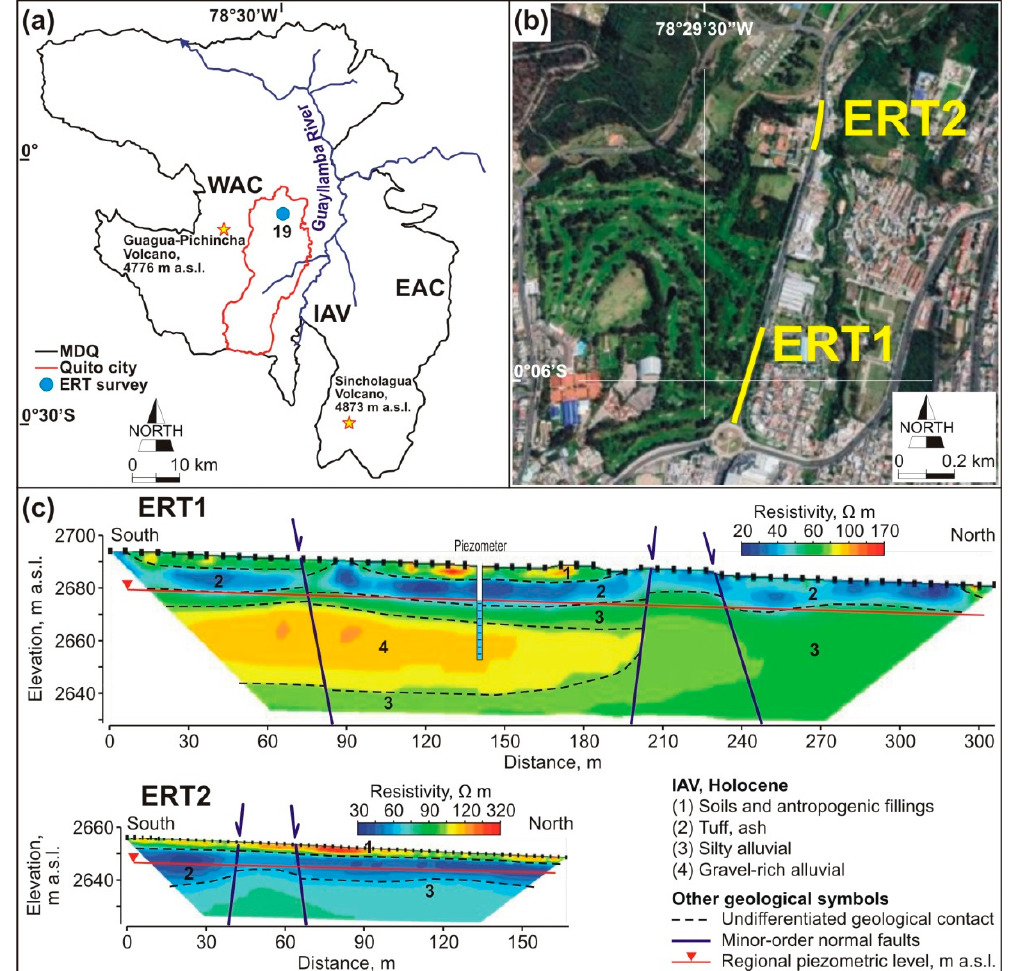
Figure 2. ( a ) General location of the selected ERT survey labelled 19 in Figure 1b and Table 2, updated and reinterpreted from Yautibug and Herrera [49]. ( b ) Detailed location of two selected ERT profiles, here called ERT1 and ERT2. ( c ) ERT1 and ERT2 profiles. The first groundwater observation (in this survey equivalent to the regional piezometric level) is singled out. Hydrogeological reinterpretation of ER models after [49] and local hydrogeological information [26,33,34]. Profiles are topographically corrected, and the vertical-to-horizontal scale ratio is 1:1.